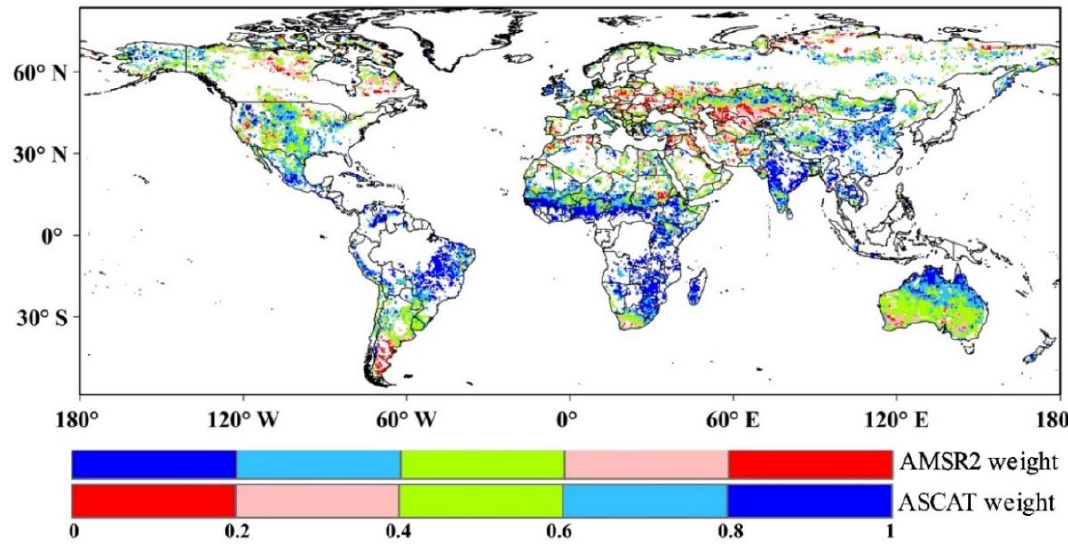
Figure 6. The spatial distribution of the global optimal weights for the parent SM products (AMSR2 and ASCAT) of the AMSR2+ASCAT merged dataset.